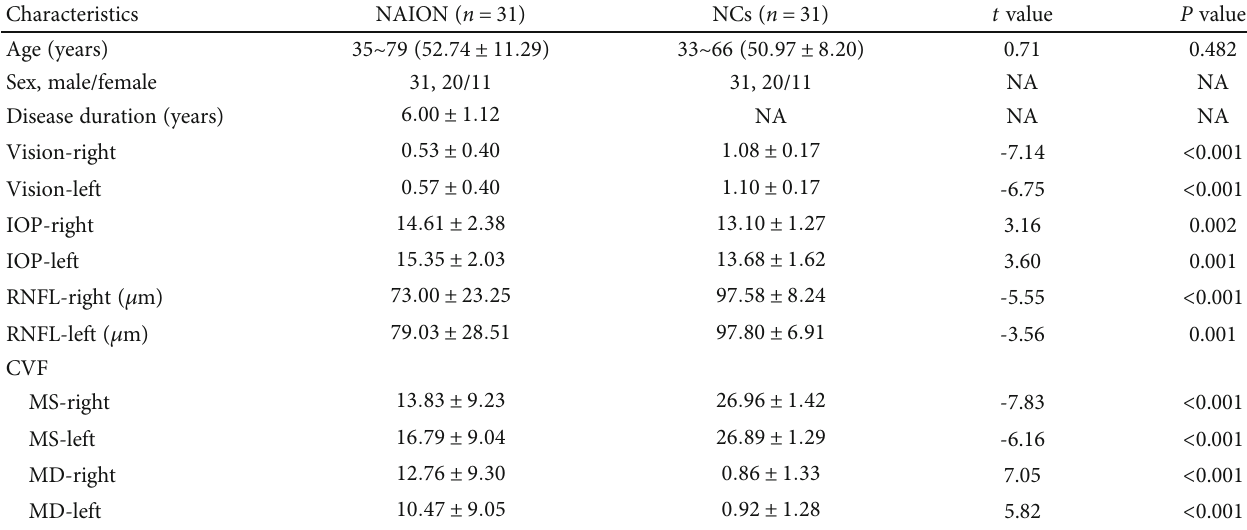
Table 1: Participant characteristics.